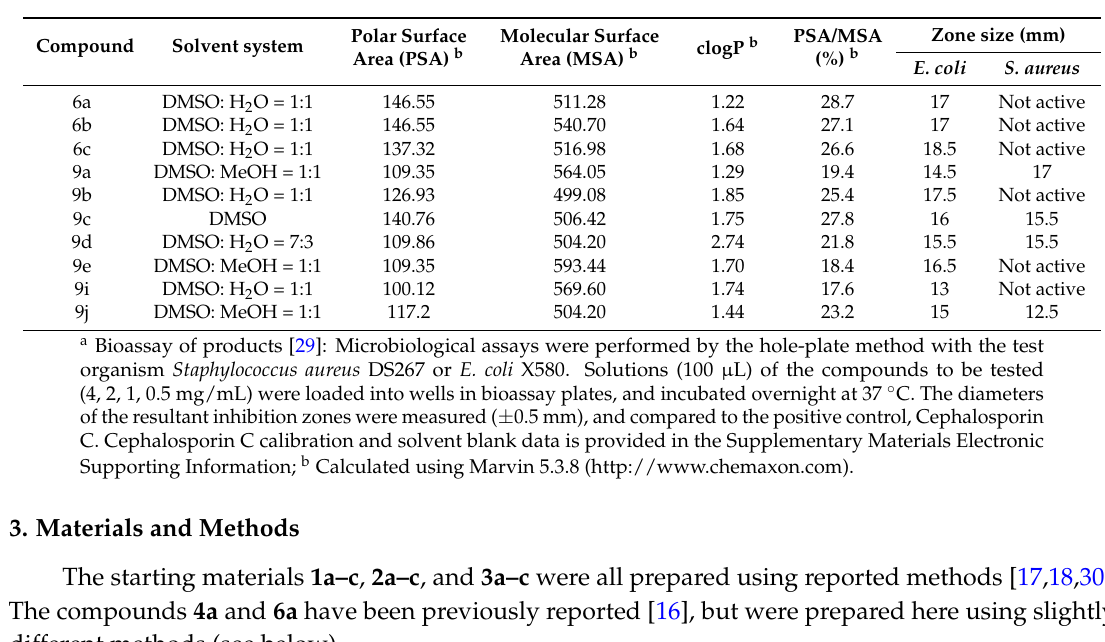
Table 2. Antibacterial assay results for selected compounds a